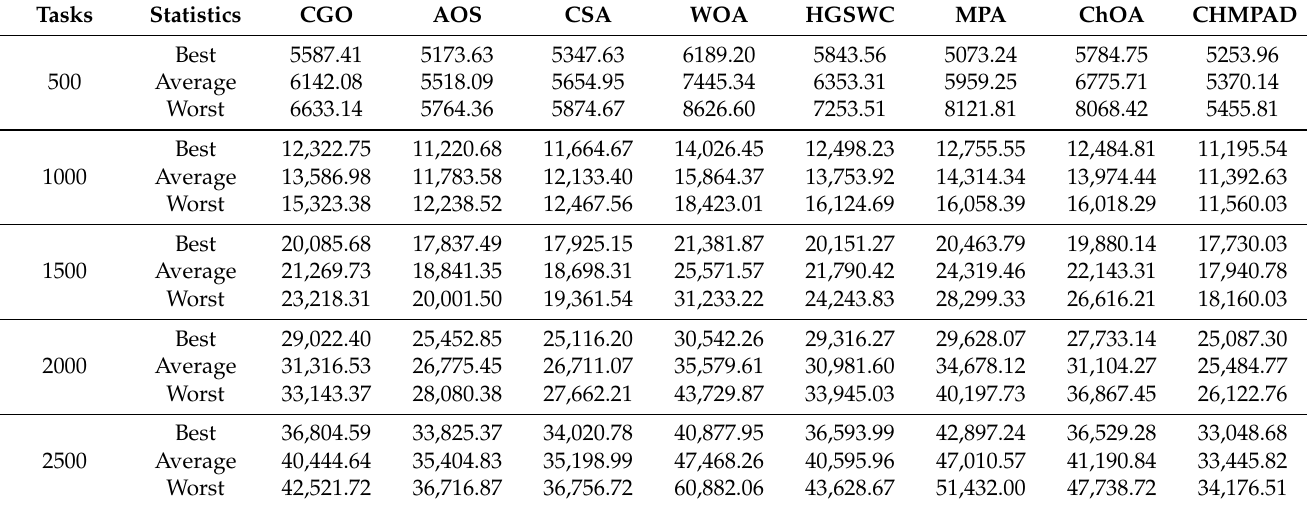
Table 5. Makespan values of CHMPAD algorithm and compared algorithms—HPC2N workload.